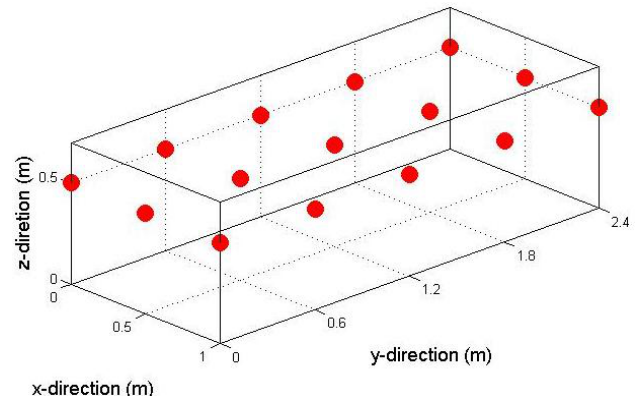
Figure 5. The configuration of the sensors network within the storage